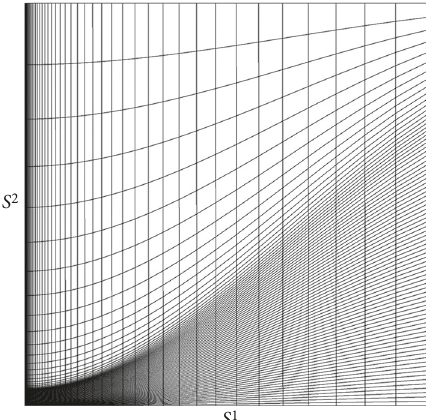
Figure 2: Computational domain defining the s i stretching computational space scaled to a unit square, as shown in Figure 2. The points along the boundaries of the s i space represent the normalized arc length distributions along the boundaries of the physical space, while the points in the interior of the s i space are interpolated algebraically from the boundaries [25].